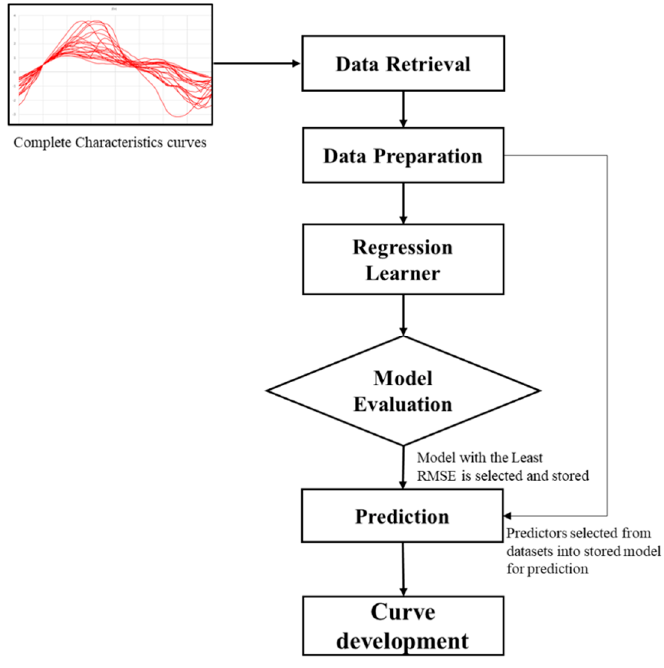
Figure 2. Overview of ML model.